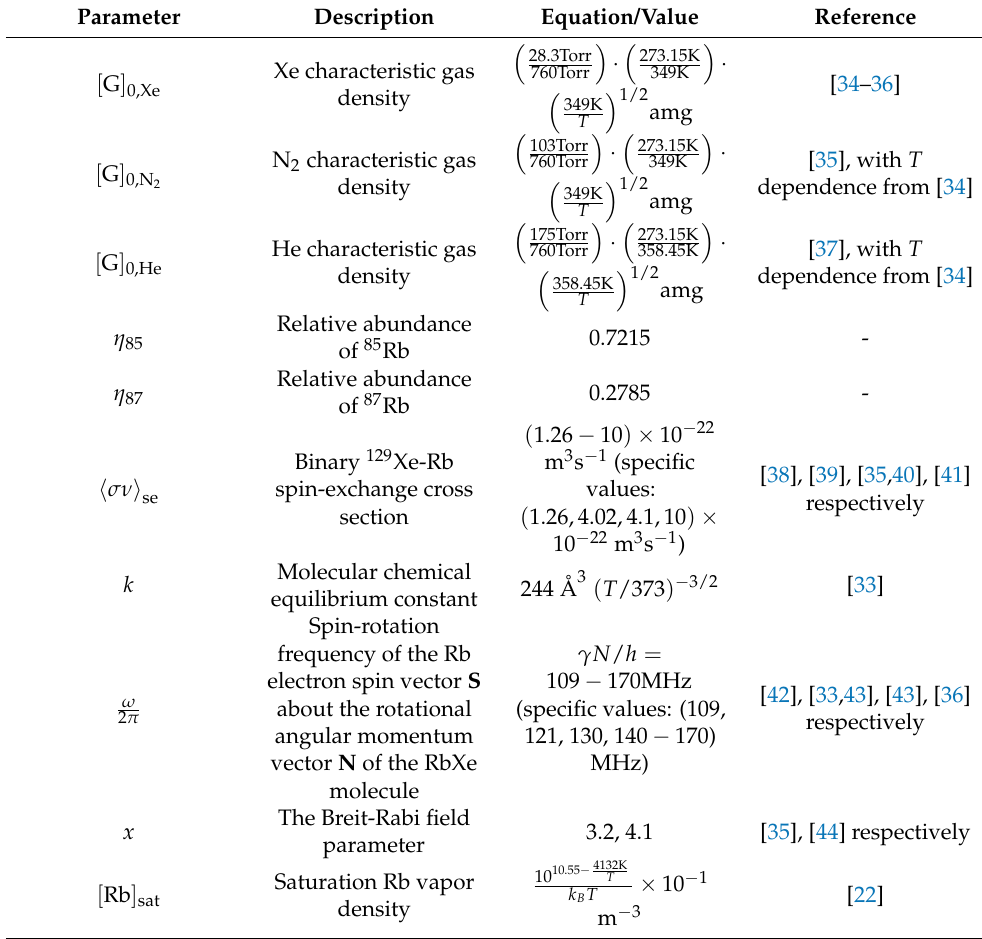
Table 1. SEOP Parameters. A range of values is given where multiple, differing, applicable values are present in the